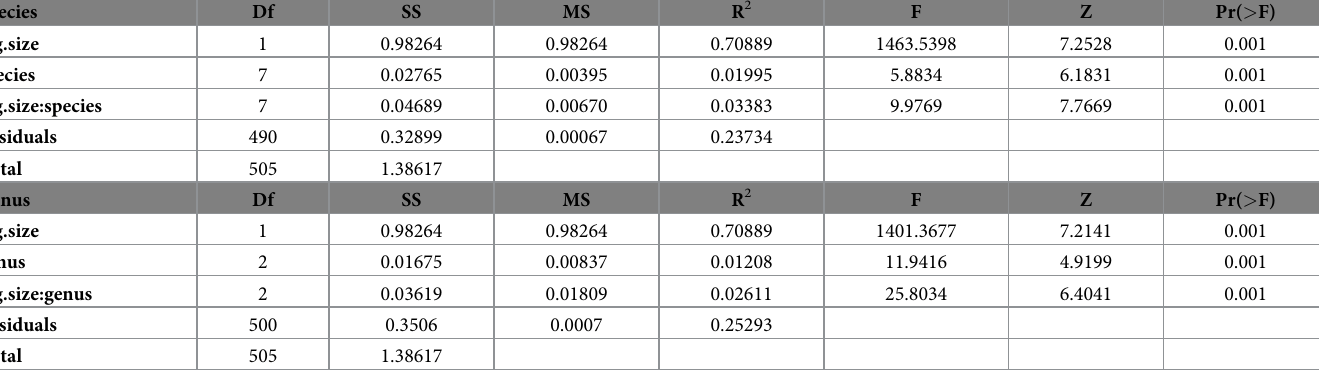
Allometric slopes differ among species (Fig 7) and genera as well. For the statistical quanti- fication of the allometric trajectories an allometric trajectory analysis (R function RRPP :: trajectory . analysis ) and a homogeneity of slopes test (HOS; R function RRPP :: pairwise ) were performed. Pairwise comparison of allometric trajectories revealed that all genera and most species have significantly different pairwise slopes (direction of shape change) in at least one of the two test procedures (see S4 File). Three species pairs did not reveal statisti- cally significant slopes in either of the two tests ( G . blakei - P . dunni , G . weitschati - G . mime- tus and G . weitschati - G . rotelliformis ). The members of the non-significant pairs all belong to type B. Whereas the minimal centroid size does not vary much between the individual species, there is more variability in later ontogenetic stages. In general type A species attain smaller maximum (centroid) sizes than type B species. Accordingly, the prevailing heterochronic pro- cess from type B to type A can be regarded as a neoteny (pedomorphosis). Table 1. Analysis of variance table obtained from the Procrustes ANOVA (R function RRPP::lm.rrpp) of the full model (PCshape~ log10CS � group) on the species and genus level. Species Df SS MS R 2 F Z Pr( > F) log.size 1